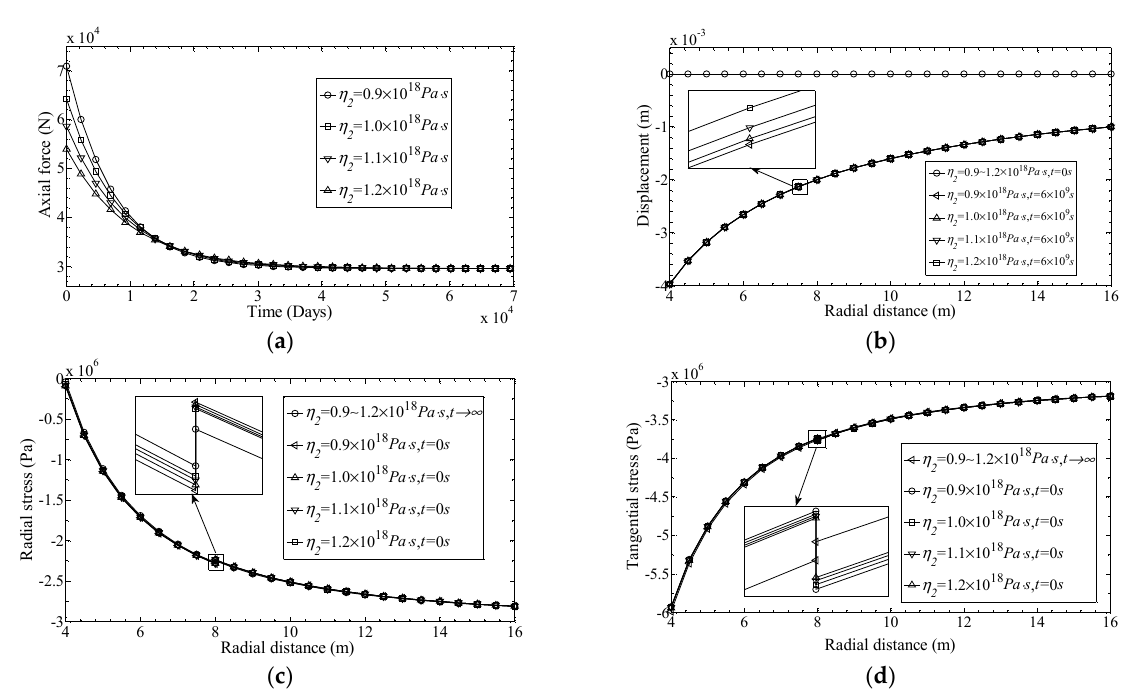
Figure 4. Mechanical states in experiments B, F, G and H. ( a ) Axial force–time curves; ( b ) Displacement–radial distance curves when the time equals zero or 6.0 × 10 9 seconds; ( c ) Radial stress–radial distance curves when the time equals zero or 6.0 × 10 9 seconds; ( d ) Tangential stress–radial distance curves when the time equals zero or 6.0 × 10 9 seconds.